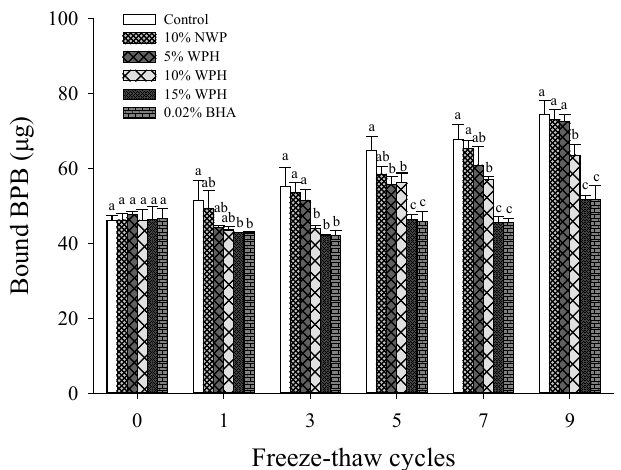
Figure 3. Changes in surface hydrophobicity of myofibrillar protein (MP) of multiple freeze–thaw (F–T) cycles of pork patties with different whey protein hydrolysate (WPH) contents. The significant differences among different samples are indicated by different lowercase letters (a–c). Control: without any additives in the sample; NWP: native whey protein; BHA: butylated hydroxyanisole; BPB: bromophenol blue.